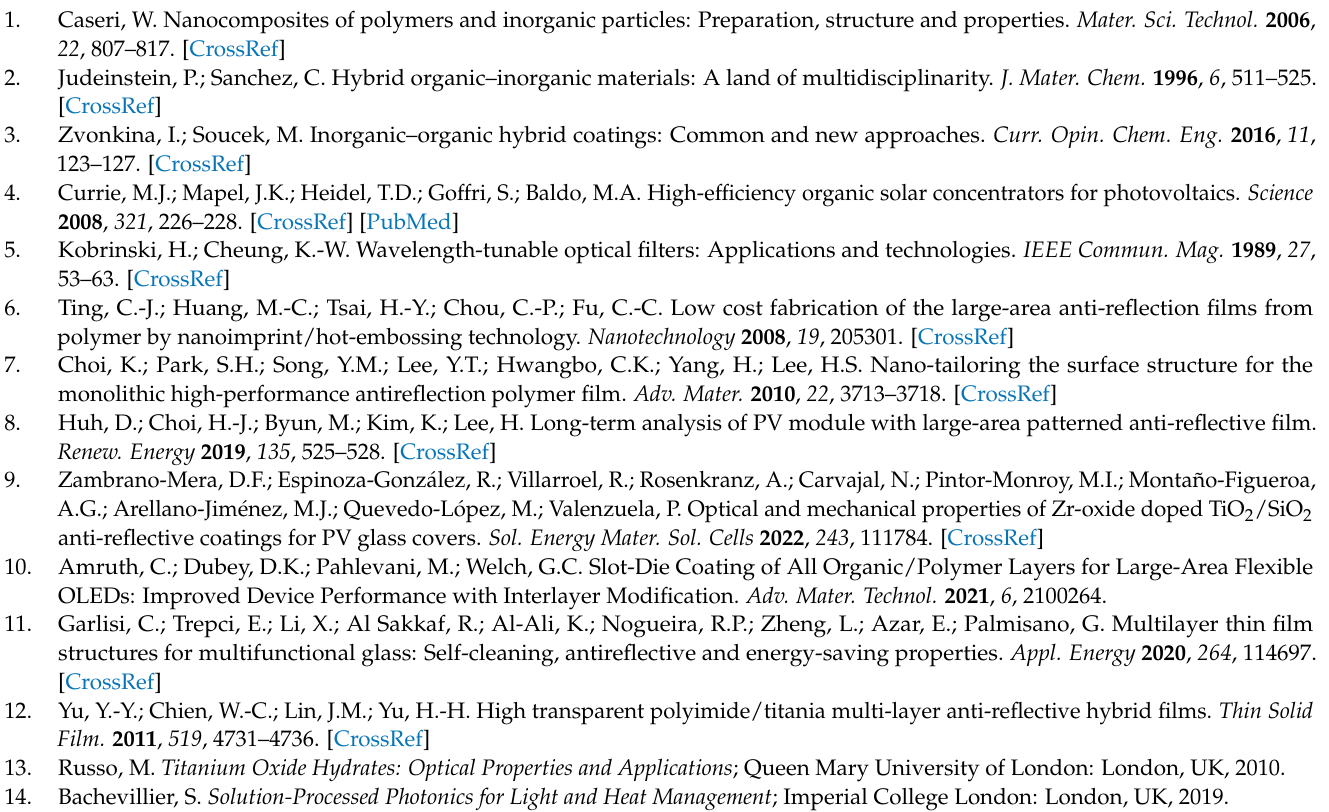
Figure S9 Performance parameters of perovskite solar cell modules with PT/PMMA structured single-sided and double-sided antireflective films prepared on cover glass. (a) J-V curves; (b) EQE plots. H: high refractive index hybrid material PT. L: low refractive index material PMMA. Table S1 Effect of viscosity of PT solution of hybrid materials with aging time. (Storage temperature 5 ◦ C, test temperature 25 ◦ C). Table S2 Molar ratio of the materials in the hybrid material PT (14.4%) when 1 g of PVA was used. Table S3 Performance parameters of perovskite solar cell modules before and after preparation of PT/CA antireflective films for the cover glass (Device area: 0.04 cm 2